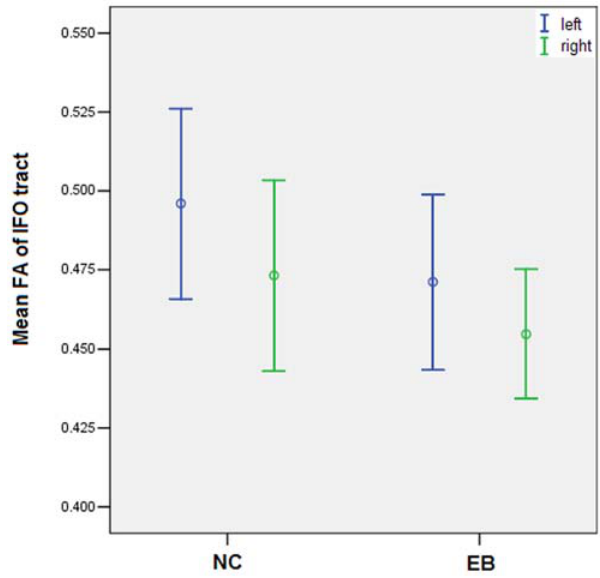
Figure 6. Mean FA of bilateral IFO fasciculi for the NC and EB groups. Open circles: mean values of the FA; error bars: standard deviations of the FA.